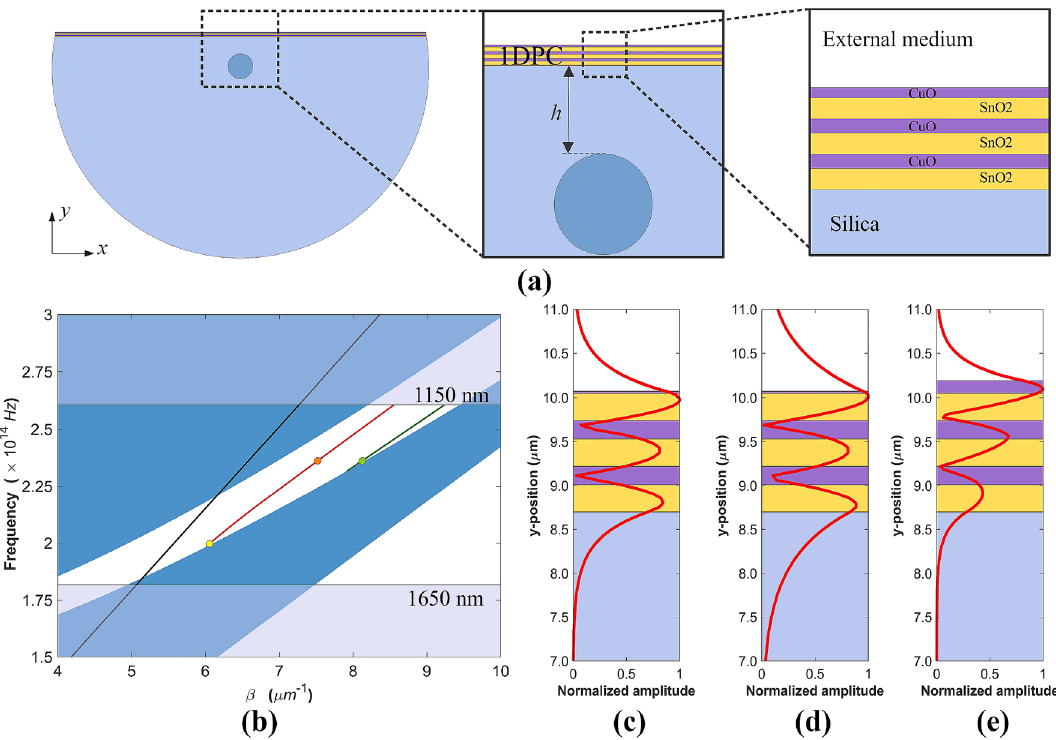
Figure 1. ( a ) Schematic of a single mode D-shaped fiber coated with a 6-layer 1DPC. The orange and purple layers represent the SnO 2 and CuO, respectively. ( b ) Band diagram of the SnO 2 /CuO 1DPC for the TE polarization. The black line is for light in the surrounding medium (1.33), the red and green lines are the calculated BSW modes at the 6-layer 1DPC with a termination layer of 24 nm and 140 nm, respectively. ( c )( d ) ( e ) BSW electric-field intensity distributions at the 1DPC with termination layer of 24 nm [at 1270 nm ( c ), and 1500 nm ( d )] and 140 nm [at 1270 nm ( e